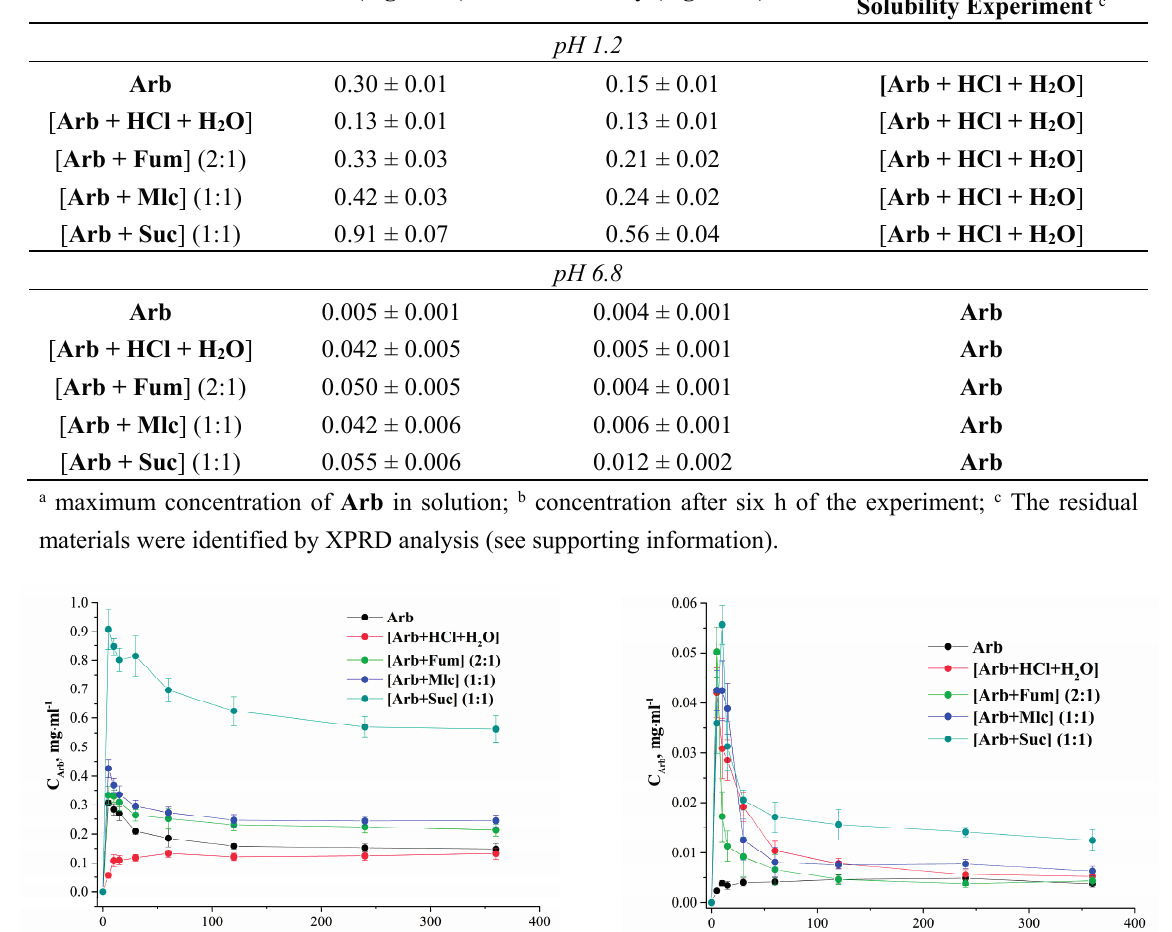
Table 5. Aqueous solubilities at 25 °C for Arb salts and pure Arb in pH 1.2 and pH 6.8 media. -- С max (mg·mL − 1 ) a Solubility (mg·mL − 1 ) b